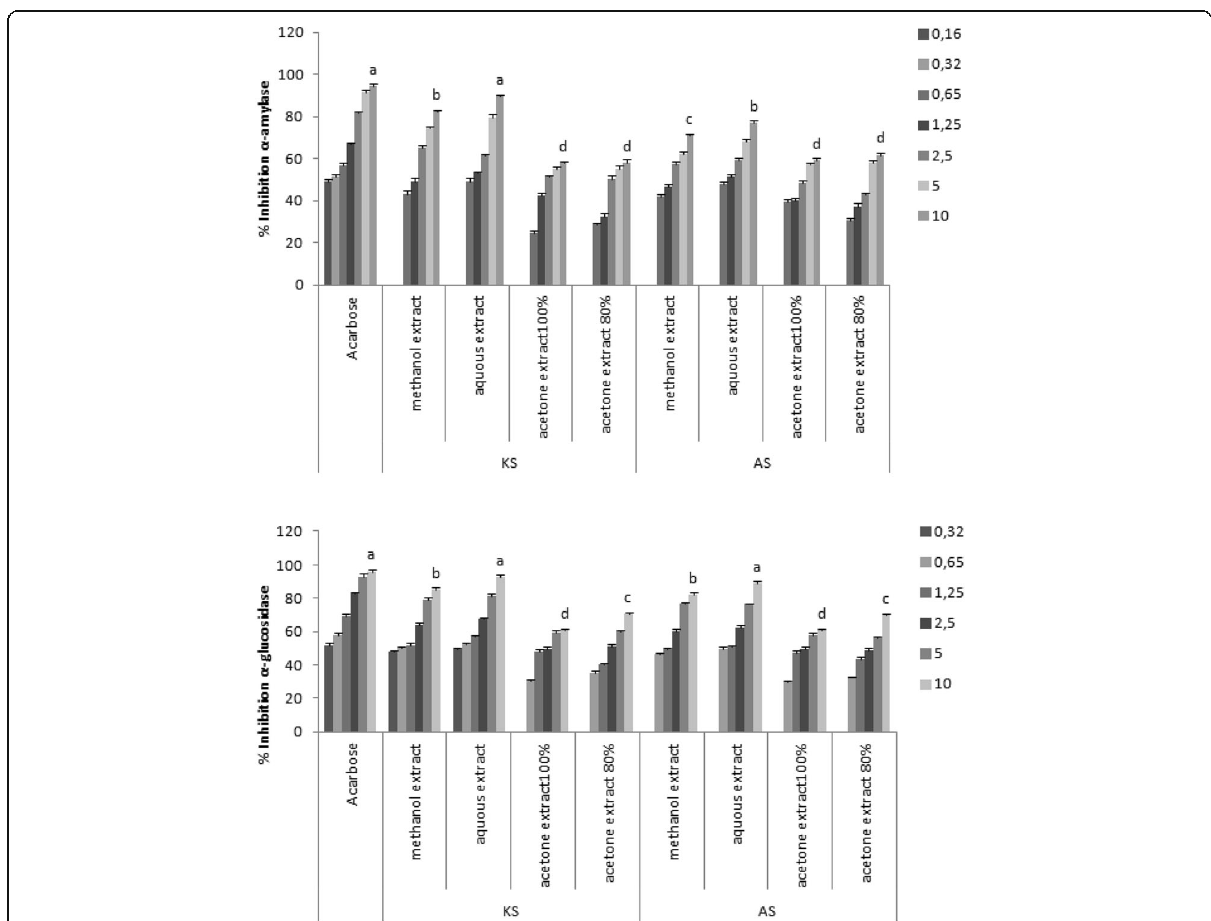
Fig. 2 Effect of different solvents on hyperglycemia key enzymes inhibition of both date seeds. Different concentrations (0.32 – 10 mg mL − 1 ) from each seed extract are used. Data expressed as means ± standard deviations of percent enzyme activity. Different lower case letters in the same types of material indicate significant differences between the different used solvents extraction ( P < 0.05). KS: Korkobbi seed, AS Arechti seed